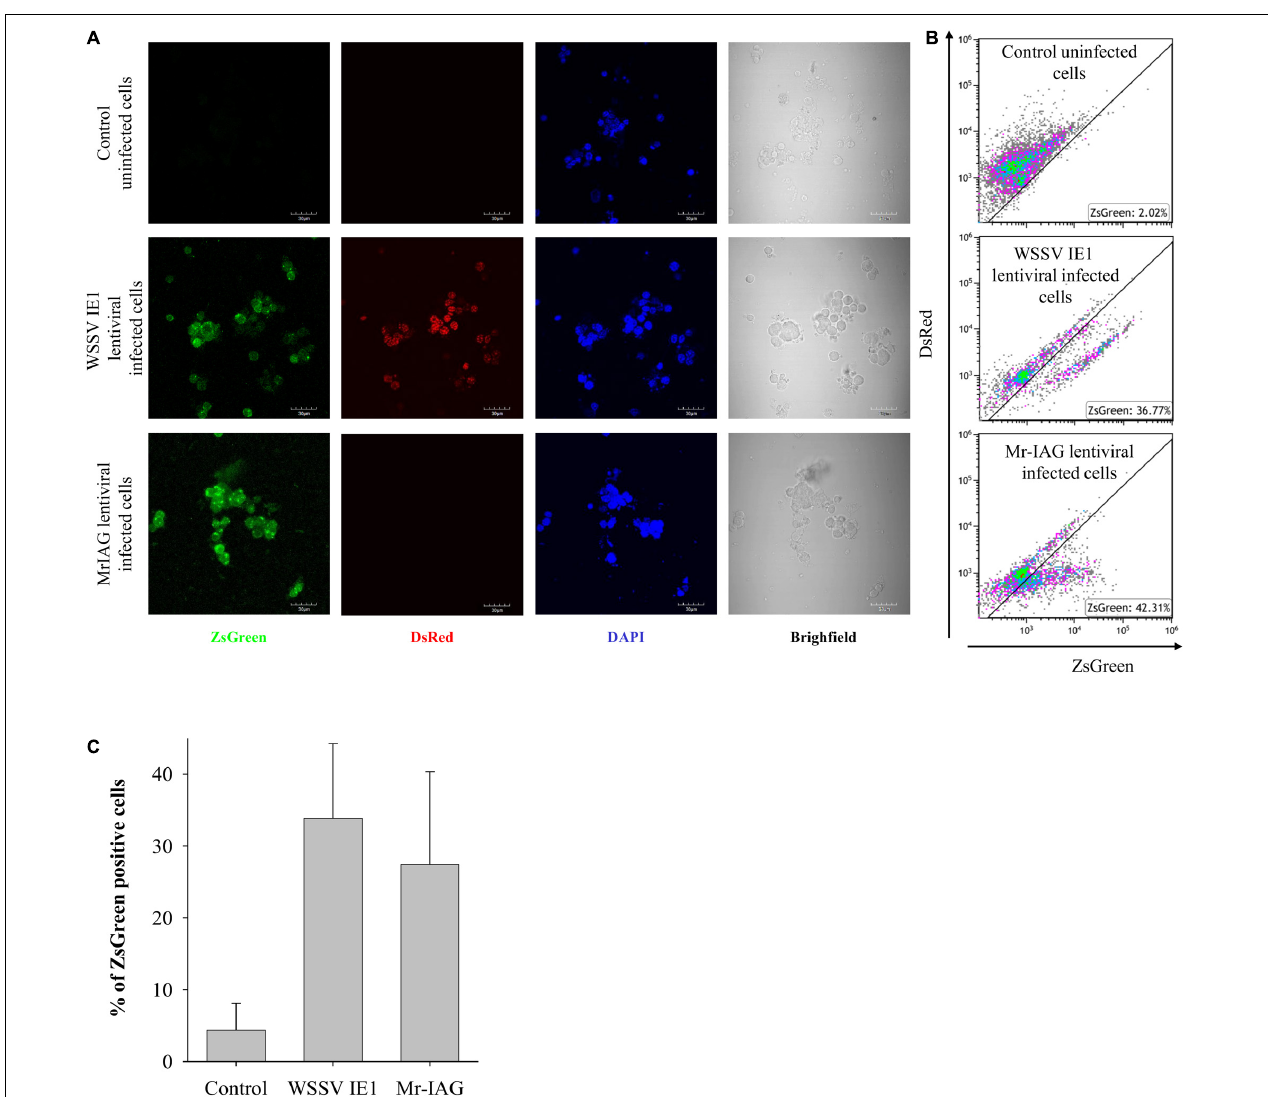
FIGURE 5 | Efficient infection of M. rosenbergii primary cell cultures with WSSV IE1 and Mr-IAG lentiviruses. M. rosenbergii primary cell cultures were infected as indicated. (A) Representative confocal microscopy images of uninfected cells, WSSV IE1-infected cells, and Mr-IAG-infected cells. Scale bar = 10 µ m. (B,C) FACS analysis of cells washed once with 1.4 × PBS (for molarity correction). Data are single discriminated and compensated. (B) Due to substantial autofluorescence of the M. rosenbergii primary cells, in order to determine specific signal, the analysis of the ZsGreen protein was performed using two-dimensional gates with DsRed and ZsGreen. The two-dimensional gating strategy is enabling gating below the autofluorescence diagonal of the specific signal. (C) Bar graph of three experiments analyzed by Flow Cytometry of ZsGreen positive populations; SD is